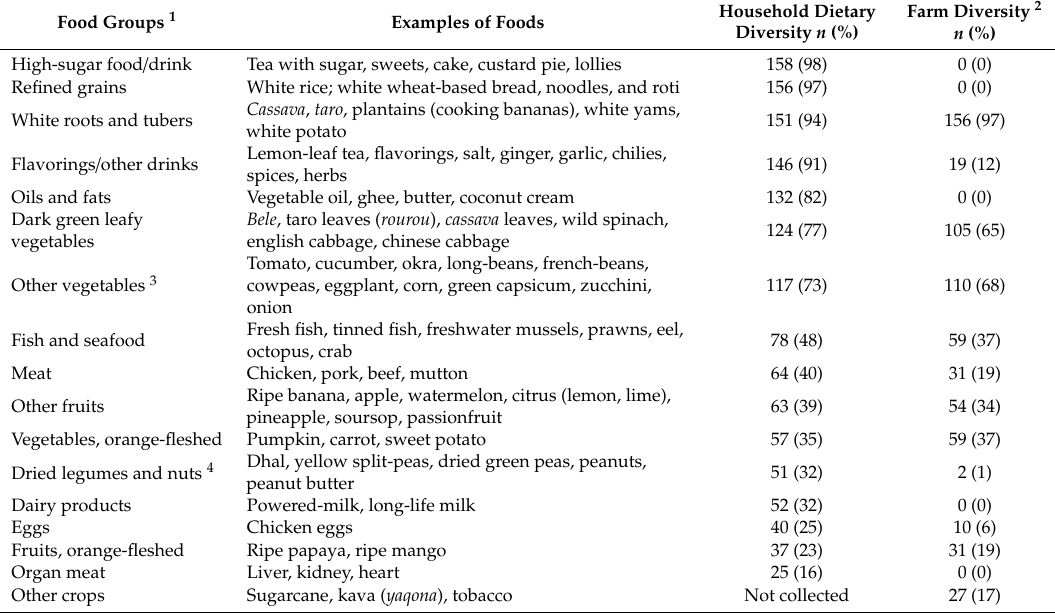
Table 2. Frequency of household dietary diversity and farm diversity by food groups ( n =